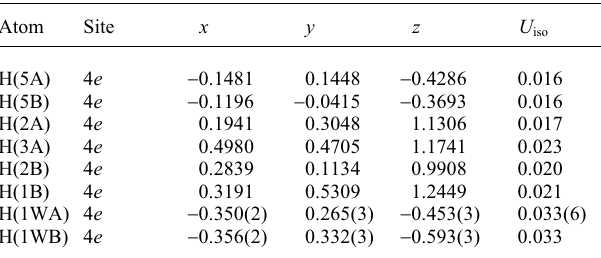
Table 2. Atomic coordinates and displacement parameters (in Å 2 )